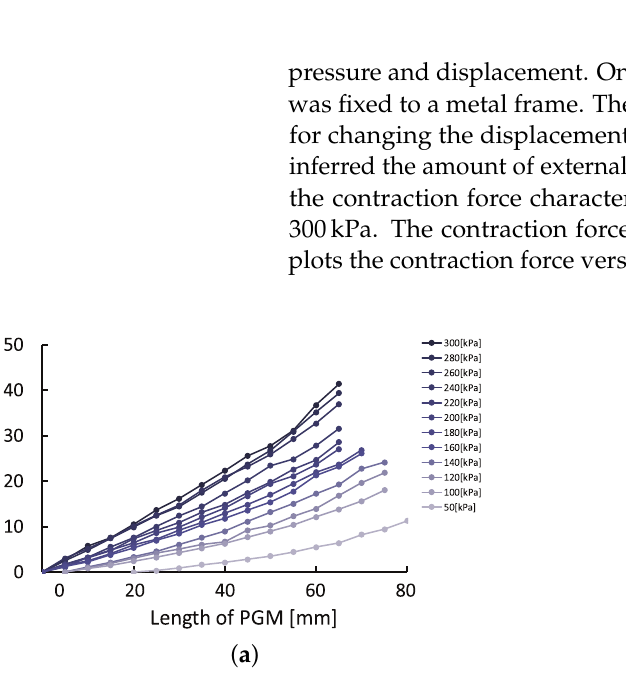
Figure 7. Force characteristics results of PGMs: ( a ) force versus length of a PGM with a natural length of 300 mm under different applied air pressures (50 to 300 kPa) and ( b ) contraction force versus air pressure in PGMs with natural lengths of 260, 280, and 300